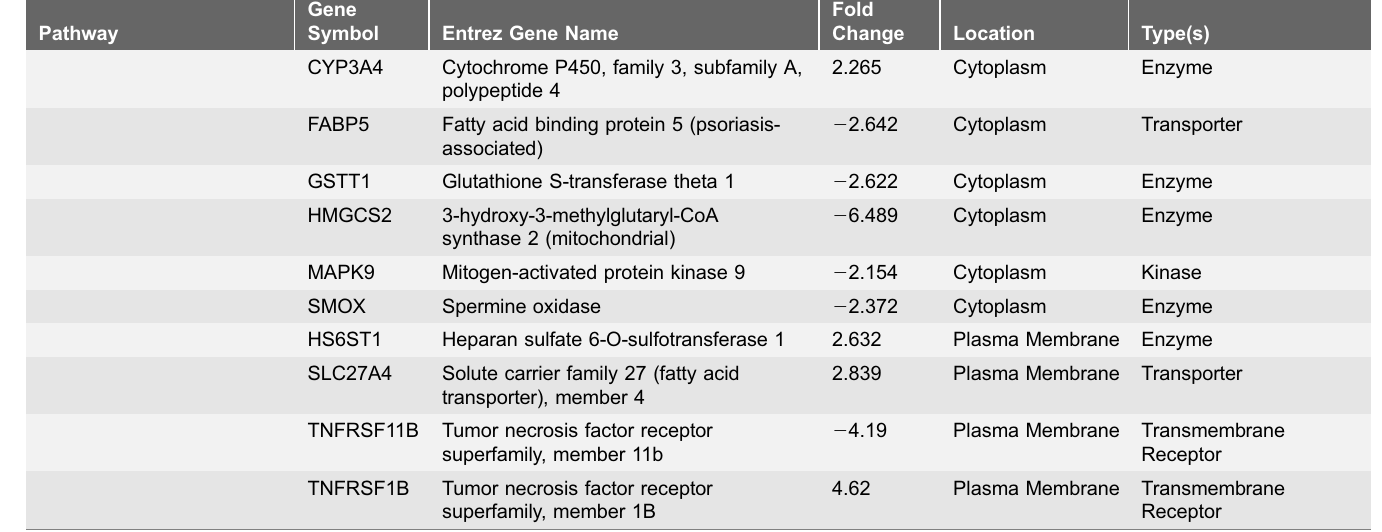
perfringens / E. maxima co-infection. Microarray hybridization identified 1,049 transcripts whose levels were altered in intestinal IELs of co-infected Ross